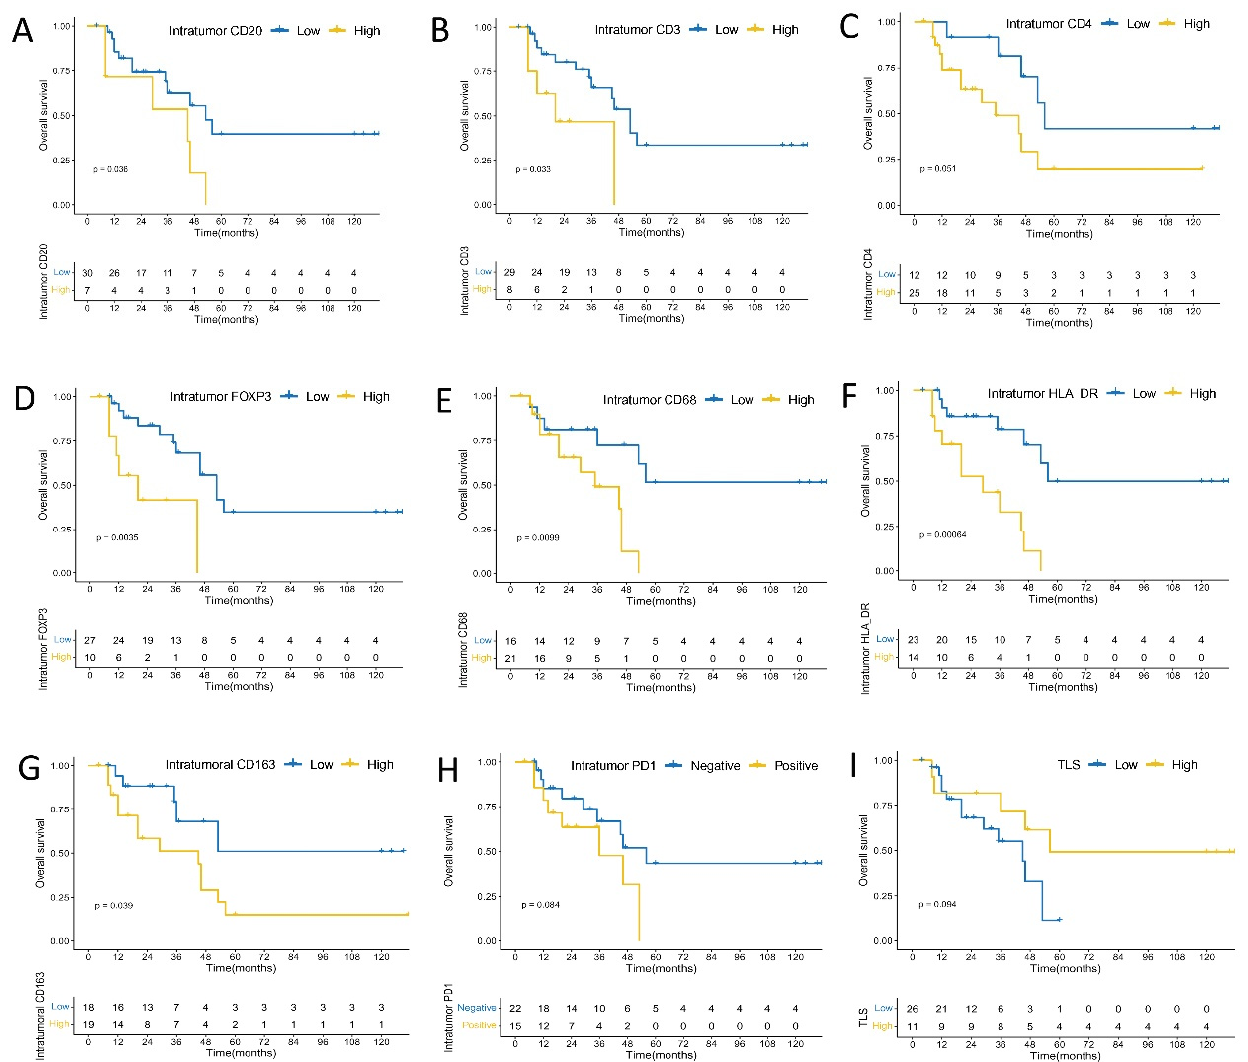
Figure 5. Kaplan–Meier analysis of intratumoral immune cells, TLS and overall survival. ( A ) CD20;